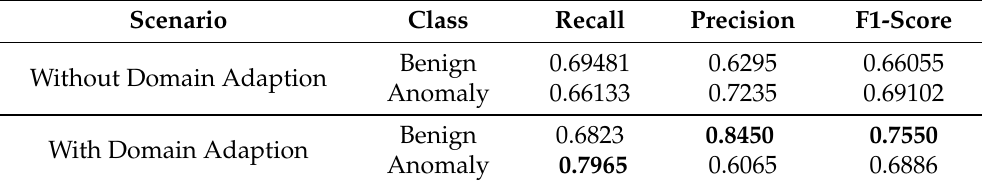
Table 3. Zero-shot scenario. Model trained on SIMARGL dataset and tested on IoT-23, (with and without domain